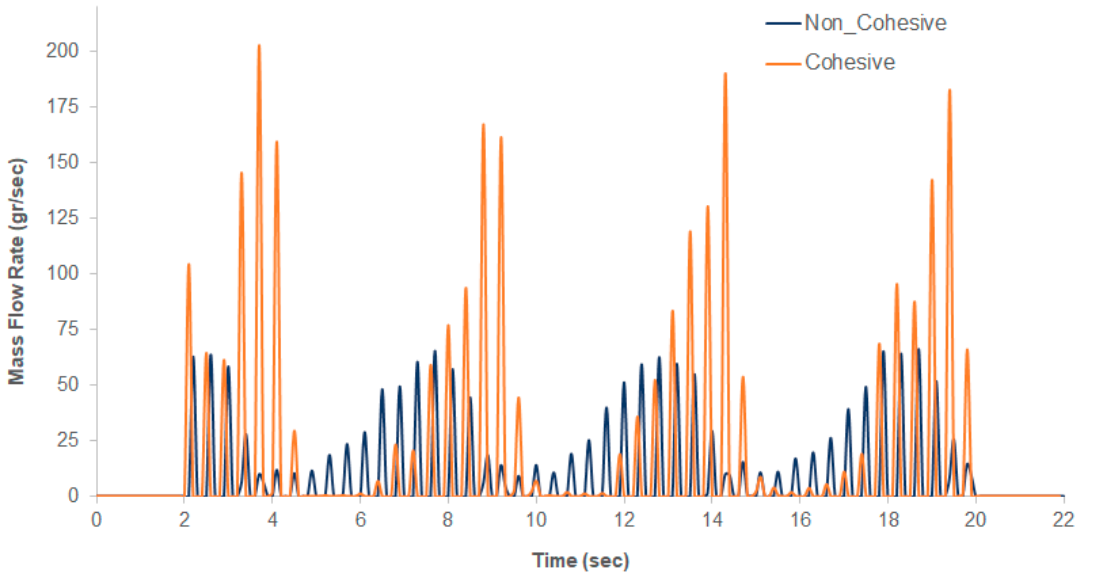
Figure 8. Mass flow rate for the free-flowing (blue) and the cohesive (orange) materials.